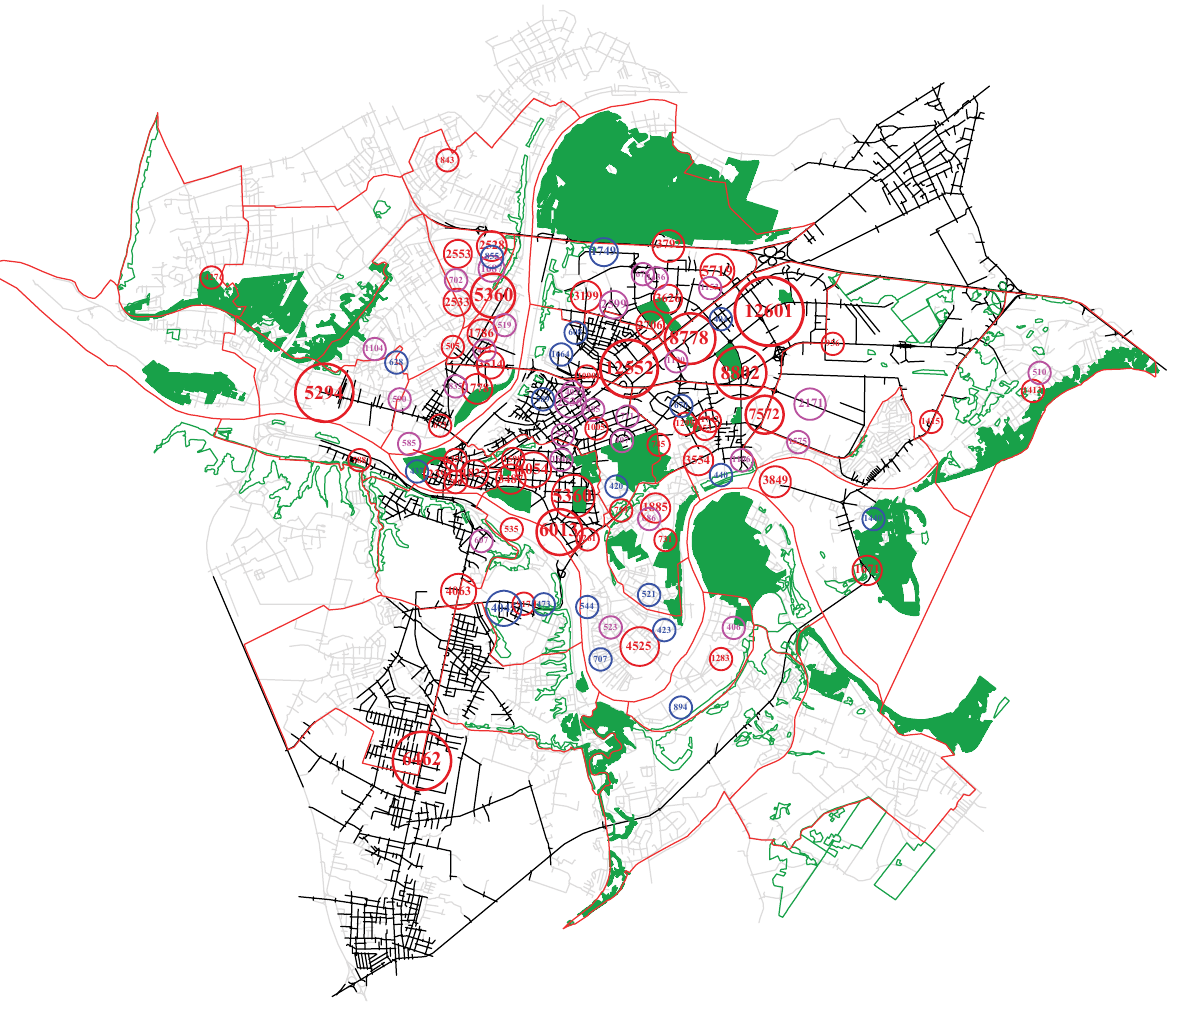
Fig. axial map of Kaunas presenting crime, green recreational areas and administrative borders of neighbourhoods. Black colour identifies 25% of the axes with the highest values of global integration. red lines identify formal boundaries of the neighbourhoods. Green areas mark green recreational zones. numbers in the circles represent crime numbers. red cirlce means integrating axes of the neighbourhoods, violet circles – axes besides the main streets, blue circles – deep axes at the periphery of the